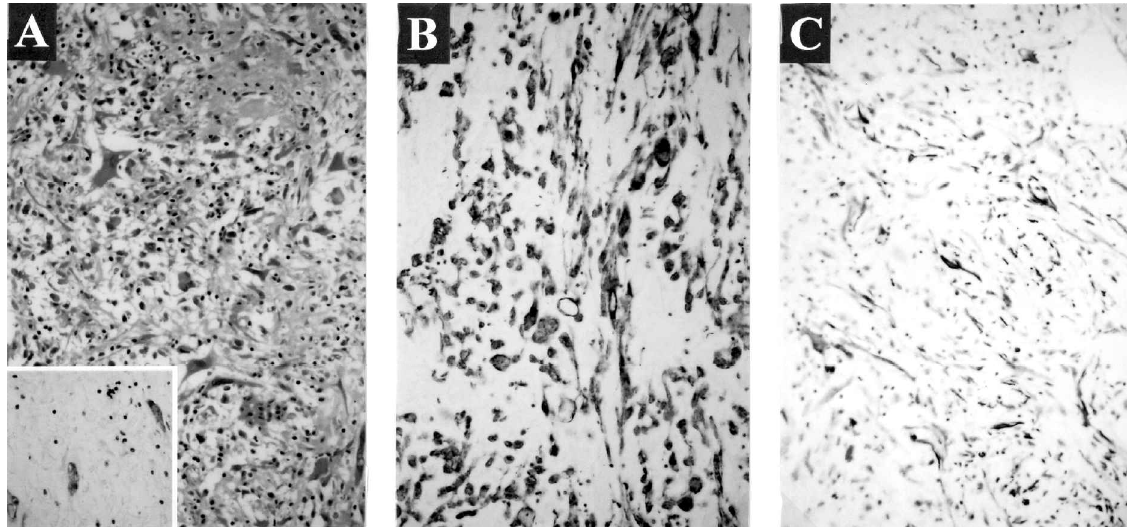
Fig. 2. (A) Pleomorphic leiomyosarcoma ( 3 180, hemolysin and eosin) (inset: negative immunohistochemical staining for b -human chorionic gonadotropin), with positive immunohistochemical staining for (B) desmin and (C) smooth muscle actin. 1 Retroperitoneal